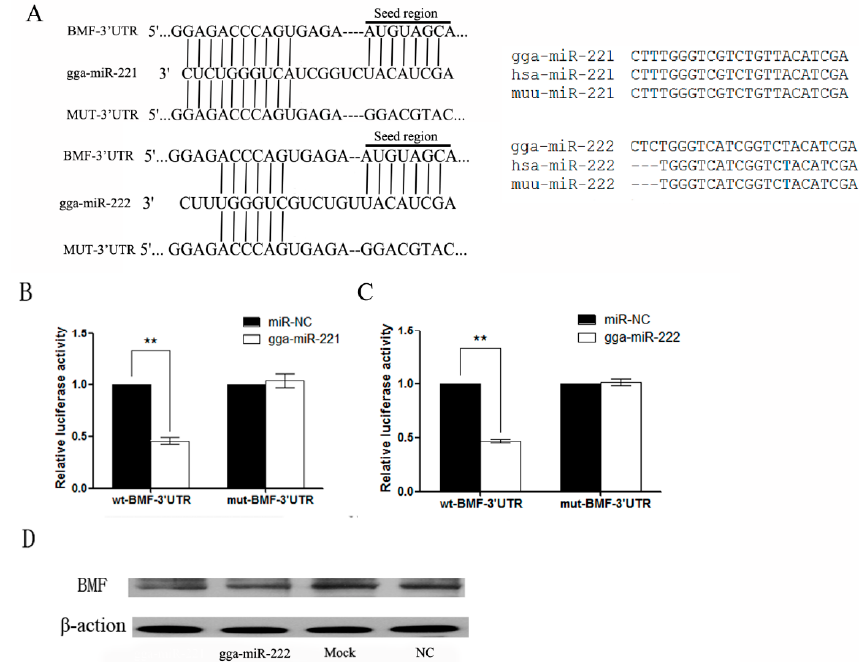
Figure 4. BMF is a direct target for gga-miR-221 and gga-miR-222. ( A ) Alignment of BMF-3’UTR, gga-miR-221,gga-miR-222 and MUT-3’UTR, where the complementary site for the seed region of gga-miR-221 and gga-miR-222 are indicated; ( B ) Differences in gga-miR-221/222, homo sapiens miR-221/222, and Mus musculus miR-221/222; ( C ) and ( D ) The regulation of luciferase activity from the BMF-3 ′ UTR is dependent on gga-miR-221 and gga-miR-222. DF-1 cells were co-transfected with gga-miR-221, gga-miR-222, miR-NC and either wt-BMF-3 1 UTR (left) or mut-BMF-3 1 UTR (right). The graphs show the means and standard errors of at least three independent experiments. ** p < 0.01, compared to miR-NC-transfected cells; ( E ) Ectopic expression of gga-miR-221 and gga-miR-222 reduced the level of BMF protein expression in DF-1 cells. β -action levels were used as a control. Each experiment was repeated three times, and each sample was assayed in